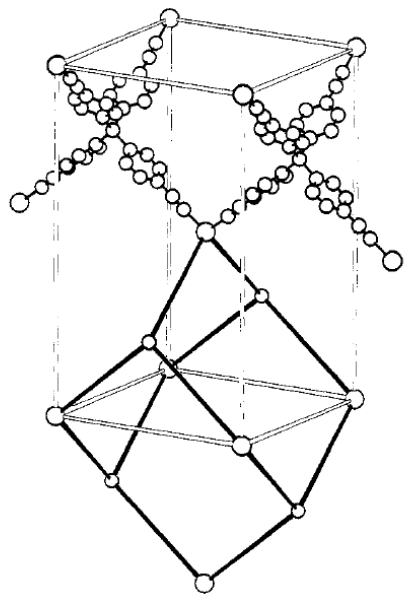
Figure 3. Crystallographic structure of coordination polymer, Cu I [C(C An adamantine-like cavity is highlighted using bold lines. Reprinted with permission from [15]. Copyright 1989 American Chemical